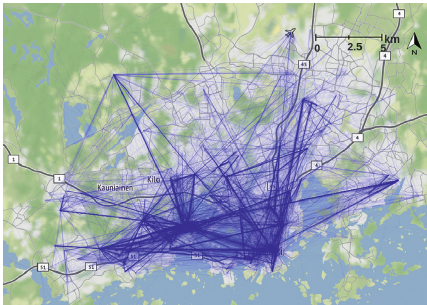
Figure 7: Desire line distribution of the observed trips, based on trip OD pairs. The lines are weighted by the repetition of unique trips. The map shows the Helsinki metropolitan region including cities of Helsinki, Espoo, and Vantaa (map tiles by Stamen Design, under CC BY 3.0; data by © OpenStreetMap, under CC BY